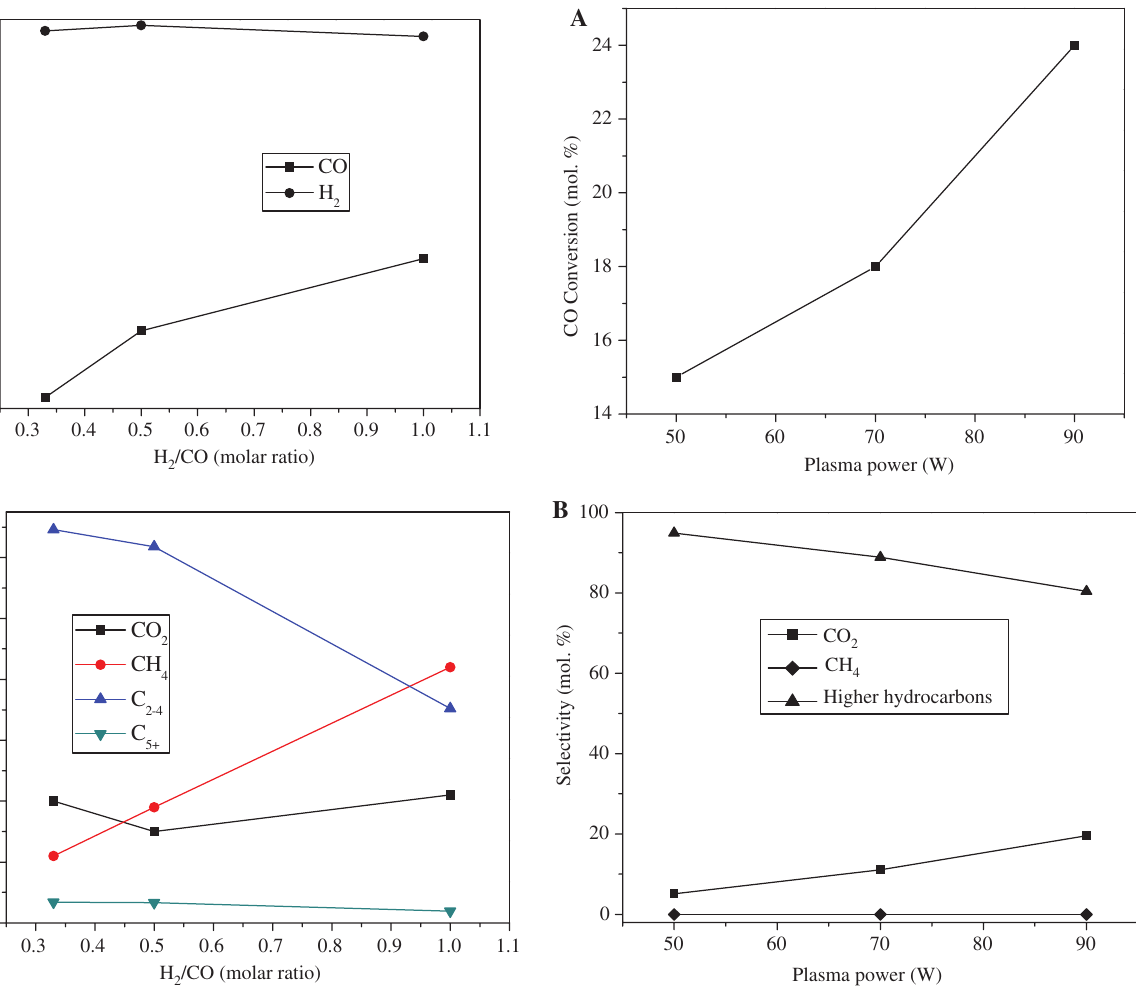
Figure 6 Influence of plasma power on FTS. (A) Conversion; (B) selectivity. (Pressure: 1 bar; flow rate: 50 ml/min; wall temperature: 373 K; H /CO in the feed: 1:1; frequency: 20 2